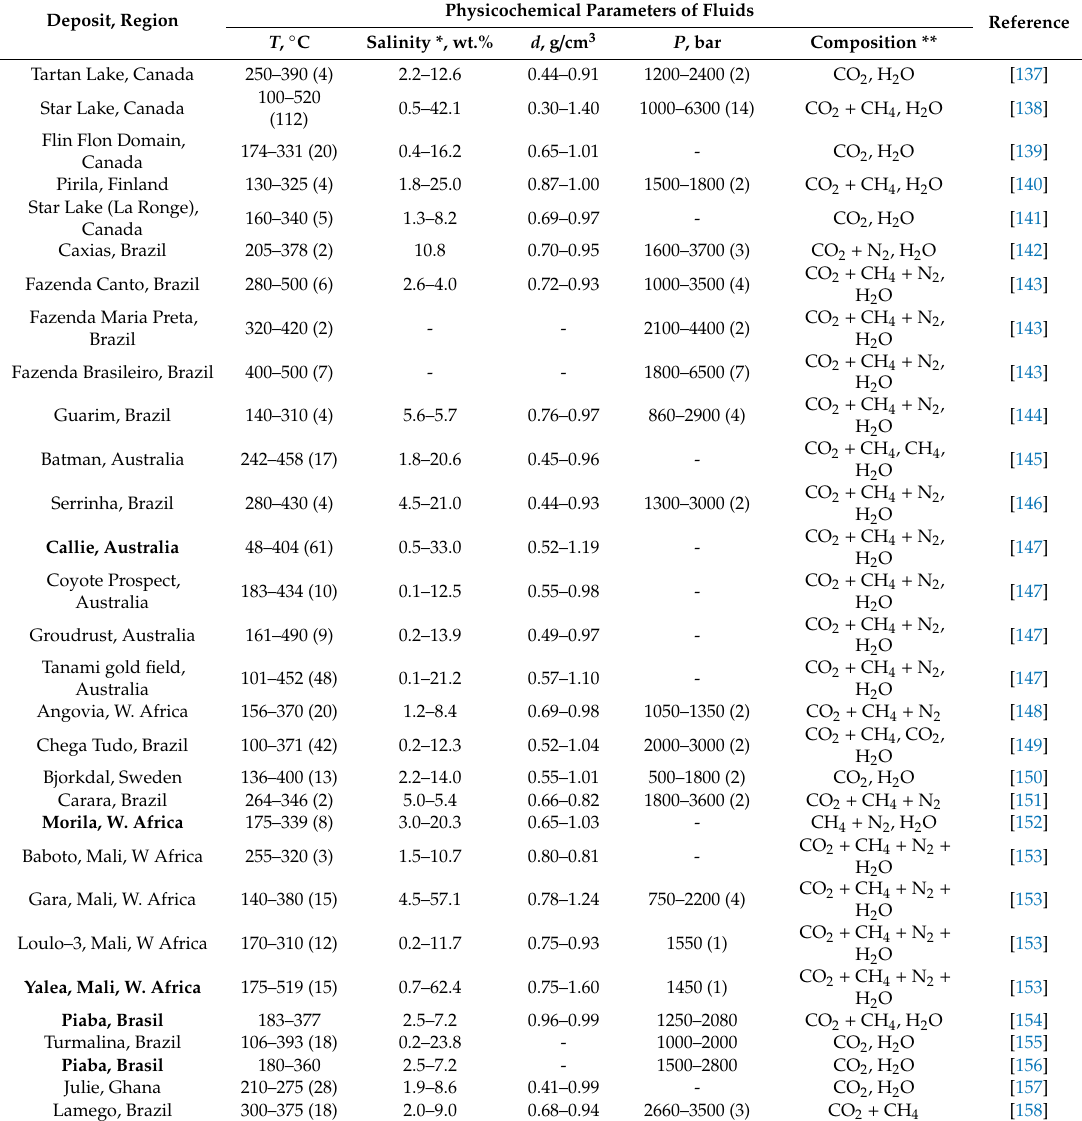
Table 6. Parameters of ore-forming fluids of Paleoproterozoic gold deposits. Deposit,